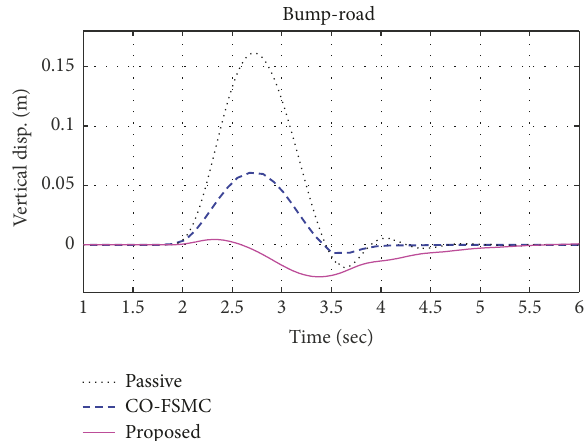
Figure 9: The bump-typed track profile: vertical chassis displace- ment corresponding to each method.